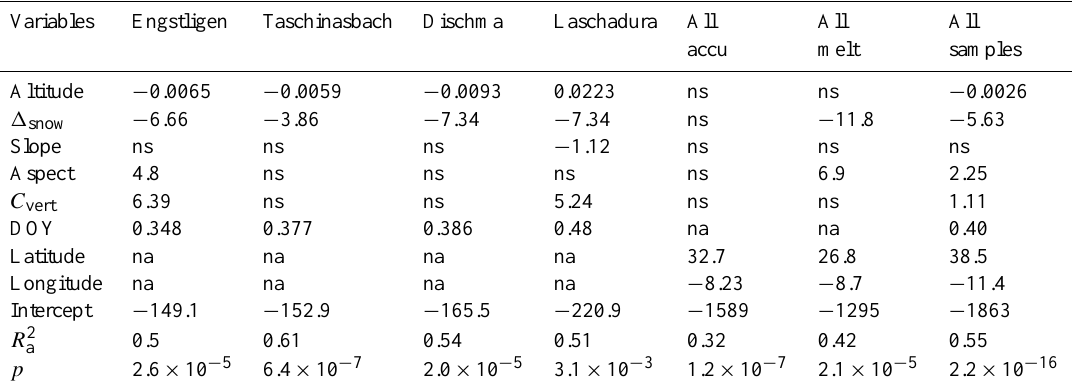
Table 2. Adjusted R 2 for computed regression equations, level of significance ( p value) and values of β -coefficients (ns=predictor variable not selected, na=not applicable).